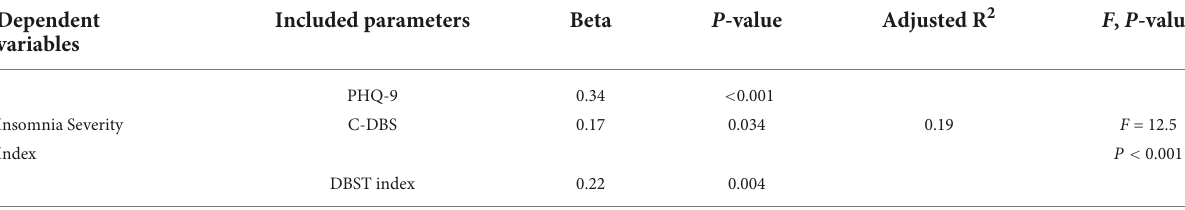
TABLE 2 Stepwise linear regression analysis to explore the variables associated with insomnia severity in patients with cancer ( n = 146). Dependent variables